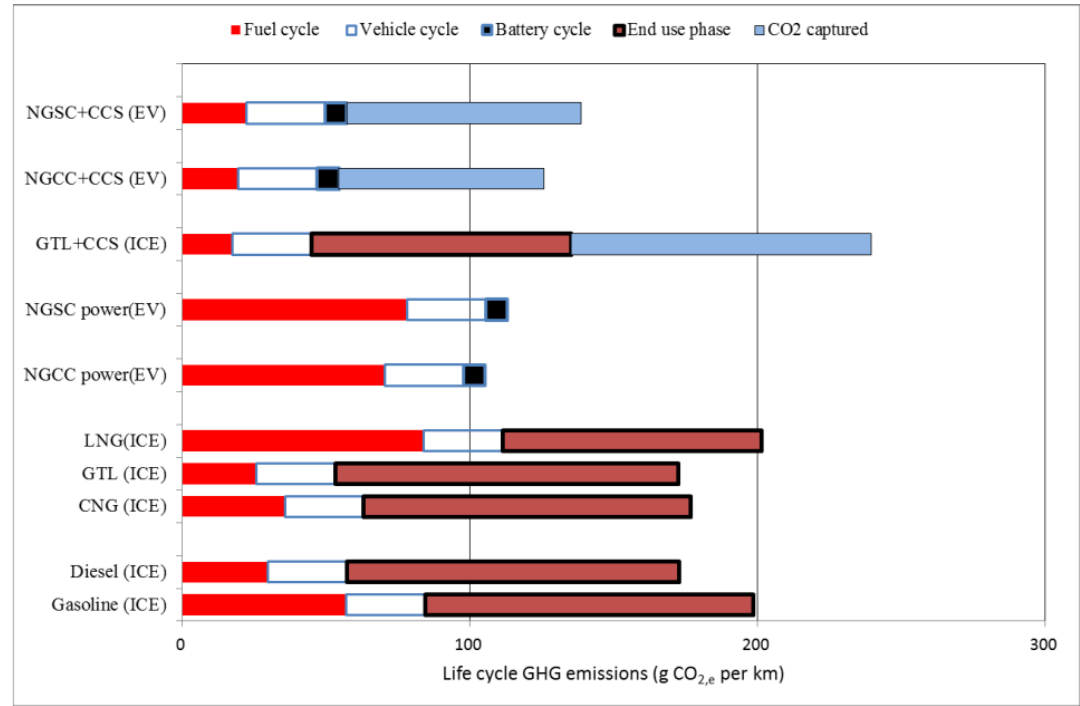
Figure 3. Life cycle GHG emissions for NG-based fuel vehicle and EV in the high process efficiency